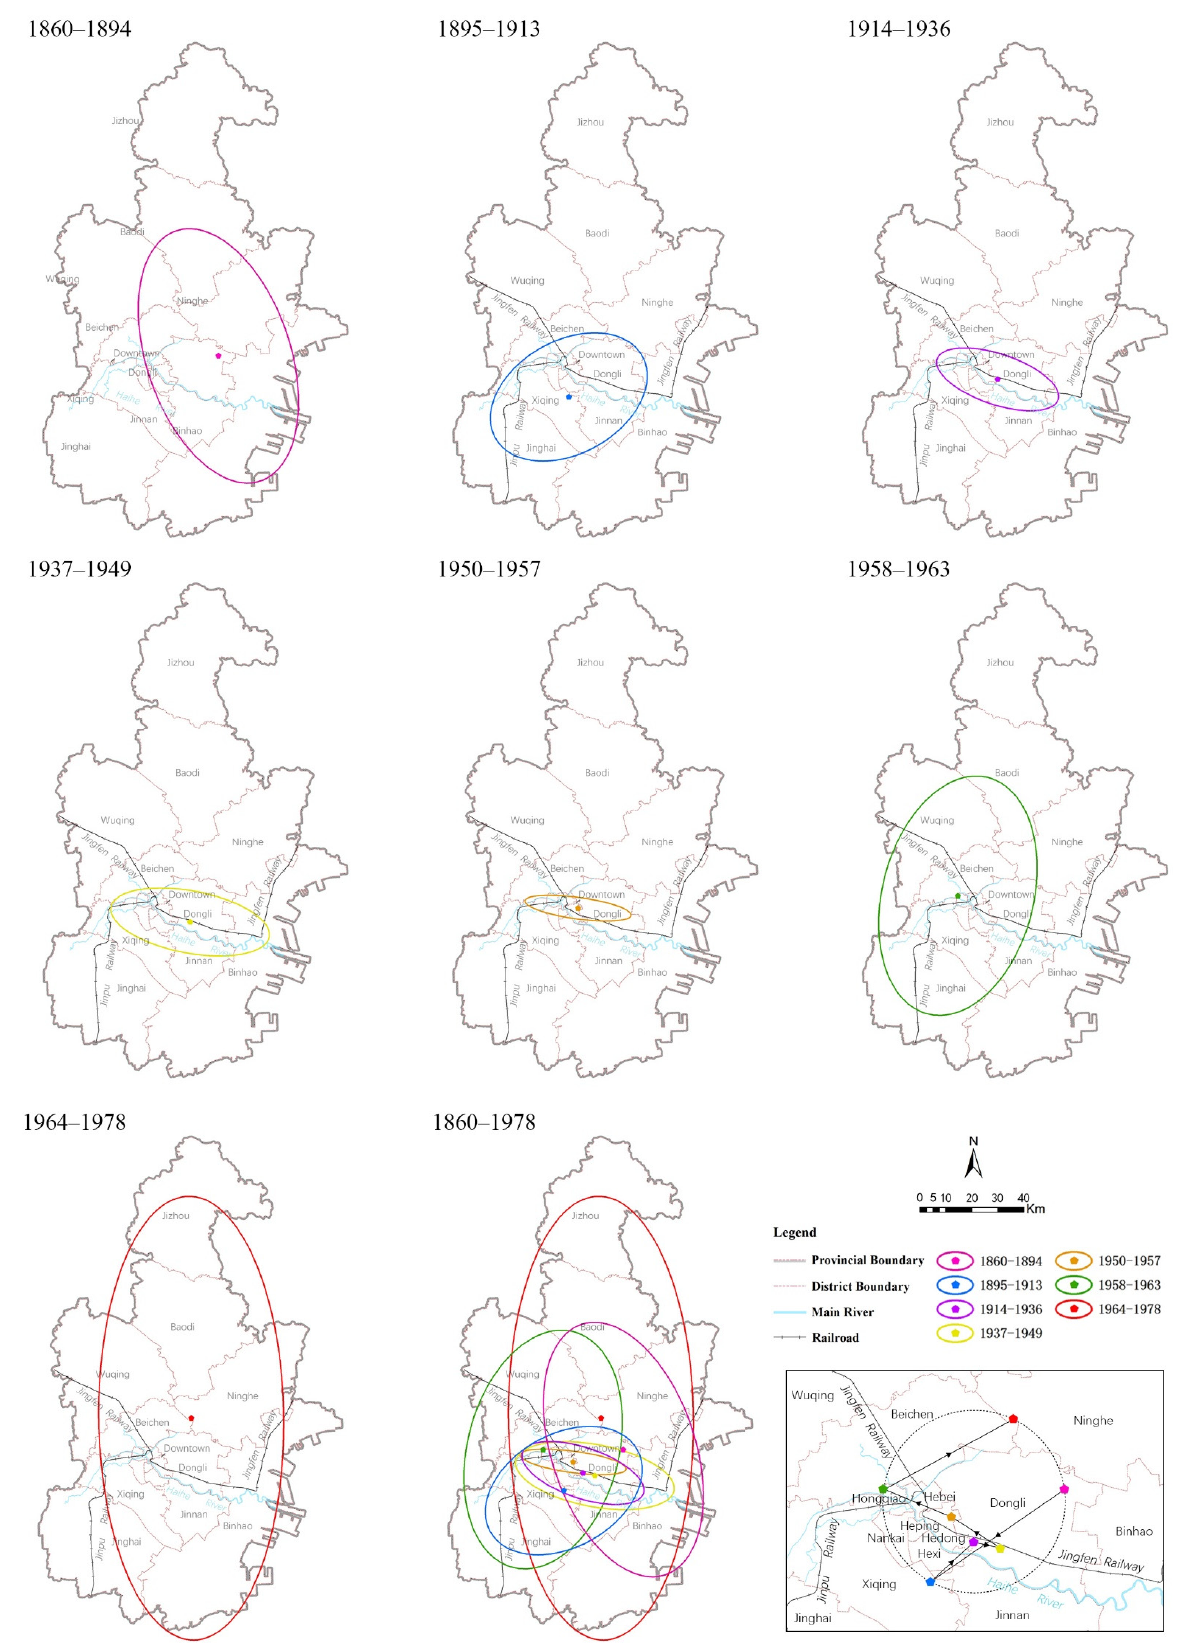
Figure 4. Spatial distribution centre of gravity and standard deviation ellipse of Tianjin’s industrial heritage by period.